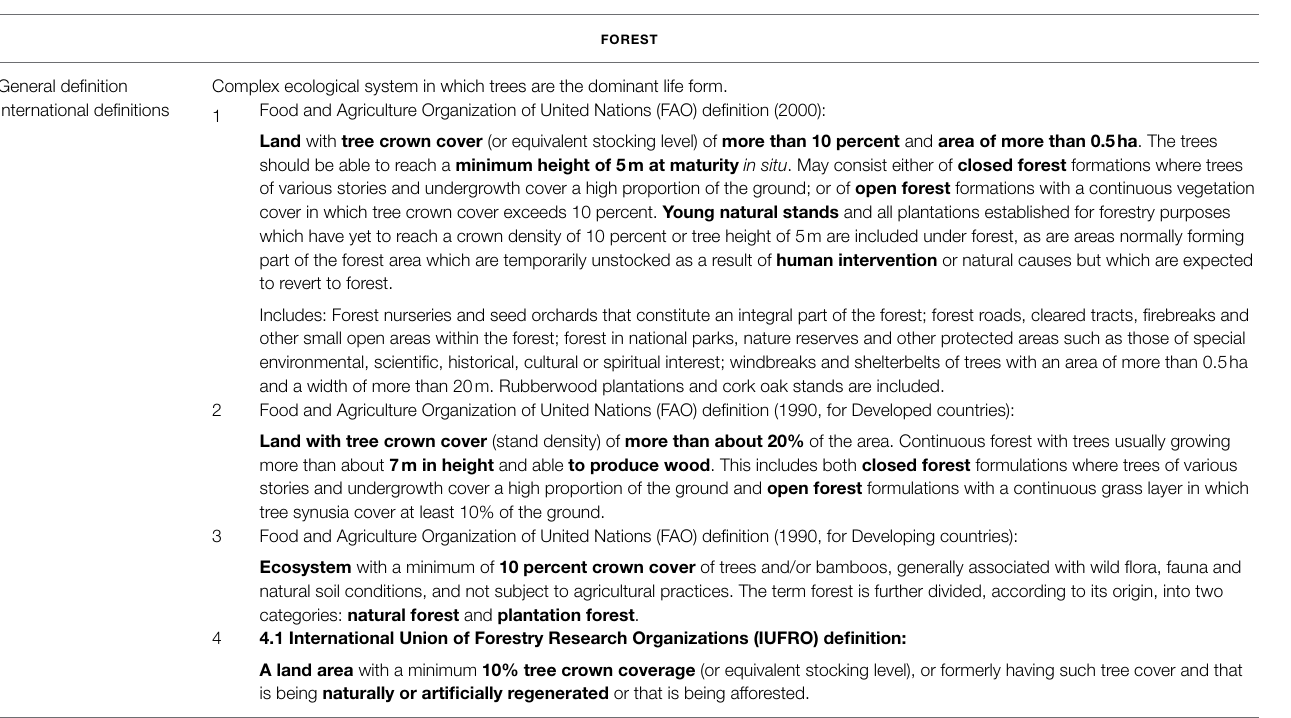
TABLE 4 | forest definitions in Schuck et al. (2002, p. 15).